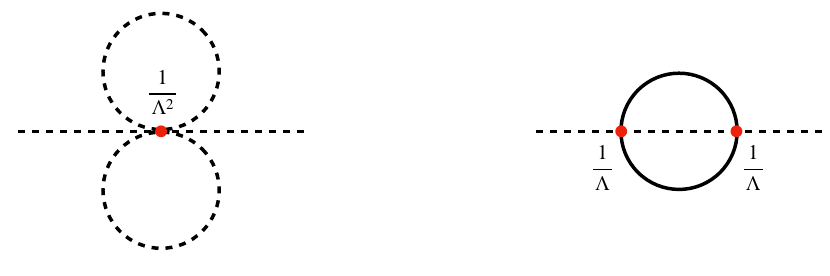
Figure 3 . Two-loop thermal corrections to the scalar mass from the scalar (left diagram) and fermionic (right diagram) degrees of freedom in models with nonrenormalizable interac- tions (2.6),